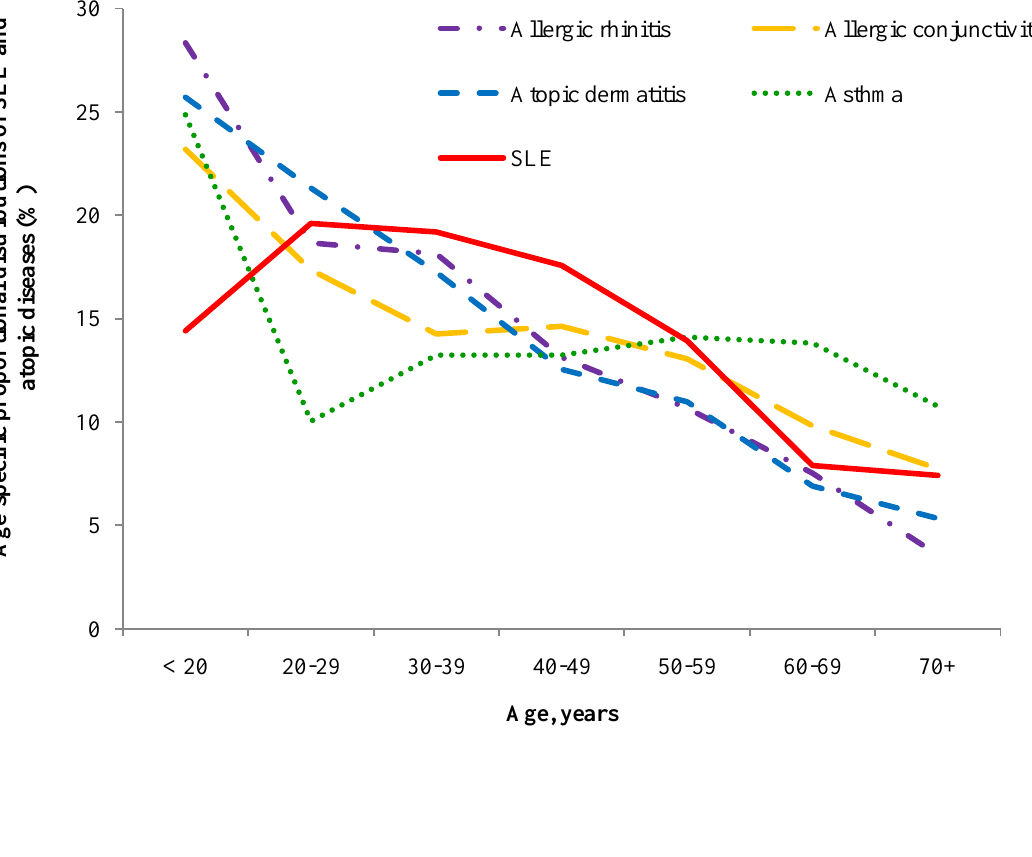
Figure 2. Age-specific proportional distributions of SLE and atopic diseases, including atopic dermatitis, allergic rhinitis, allergic conjunctivitis, atopic dermatitis and